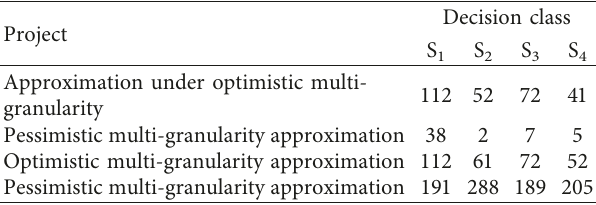
Table 2: Multiple granularity correlation approximations.